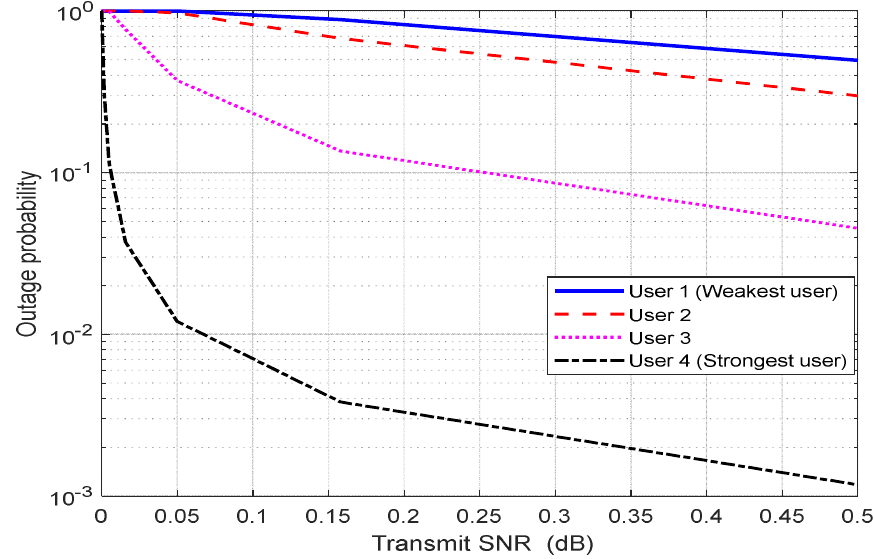
Figure 15. OP vs. SNR for four users with varying distances and BW 80 MHz for UL NOMA.